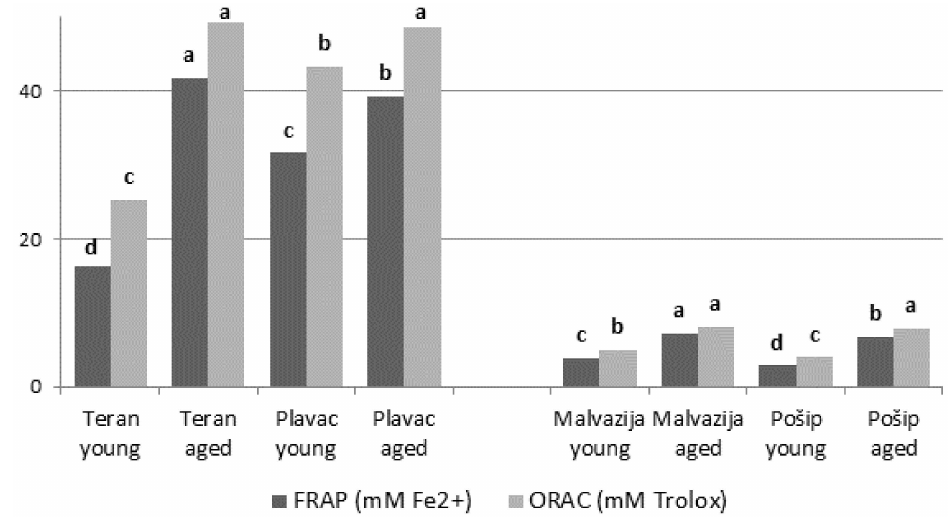
Figure 2. Antioxidant activity (FRAP and ORAC) of young and aged Croatian wines; red—Teran and Plavac mali, and white—Malvazija istarska and Pošip: young white wines produced without maceration, young red wines produced with standard 7–8 days maceration, aged wines produced with maceration of 7 days (white wines) and prolonged 15–30 days (red wines) followed by maturation in oak barrels. Each value represents the mean ± standard deviation; different lowercase letters represent statistically significant differences between wine samples at p < 0.05 obtained by one-way ANOVA and least significant difference (LSD)